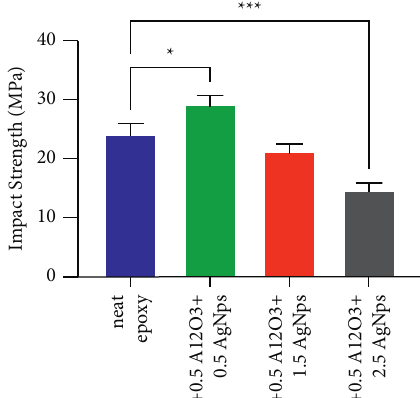
Figure 4: Impact strength for pristine bioepoxy and bioepoxy reinforced by various weight fractions of Al 2 O 3 -AgNps. Asterisks indicate that results significantly different to the unmodified control ( ∗ p < 0 . 05; ∗∗∗ p < 0 . 001).